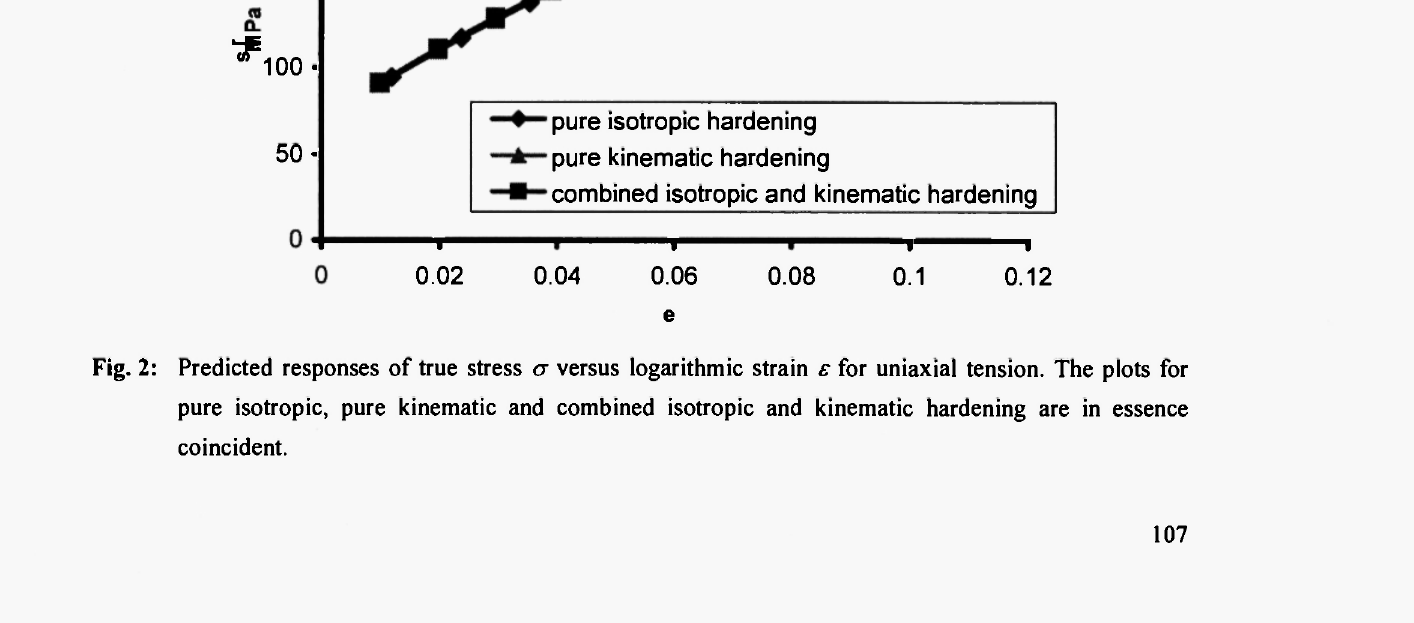
Fig. 2: Predicted responses of true stress σ versus logarithmic strain ε for uniaxial tension. The plots for pure isotropic, pure kinematic and combined isotropic and kinematic hardening are in essence